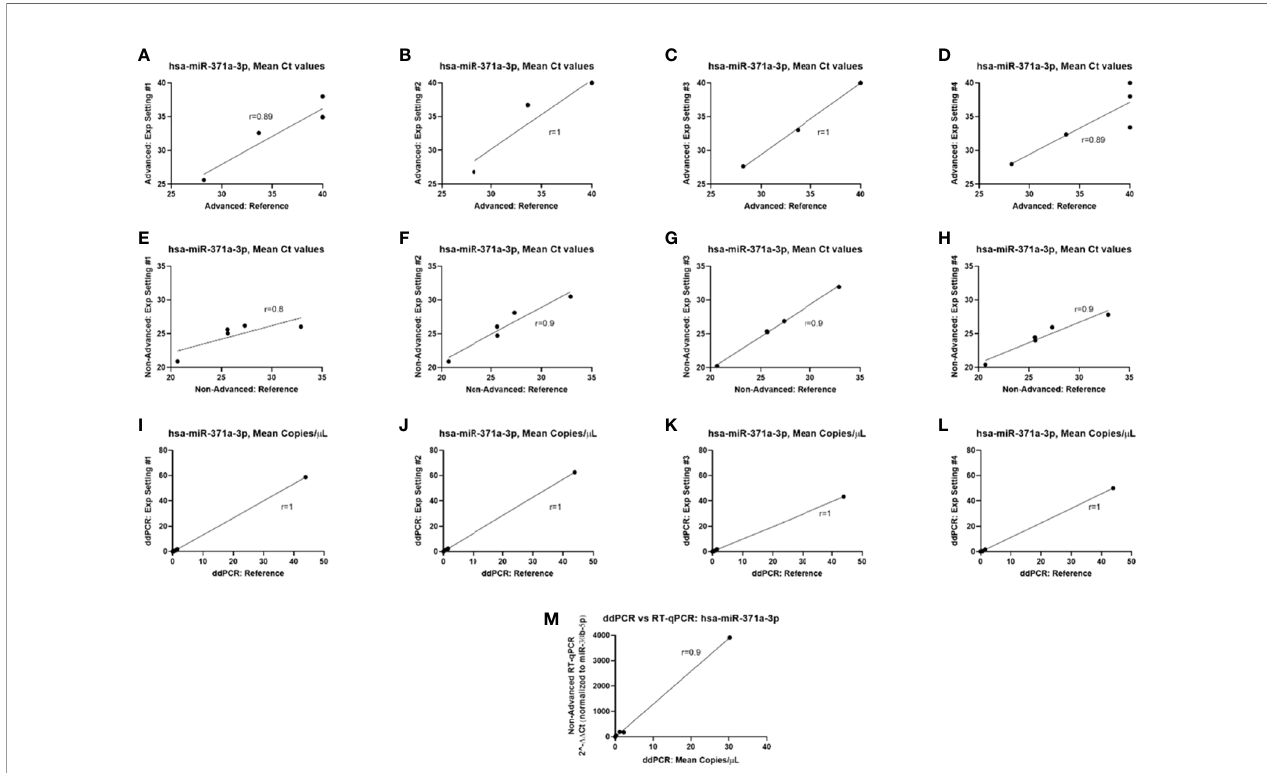
FIGURE 6 | Correlation between hsa-miR-371a-3p quanti fi cations. (A – D ) TaqMan Advanced (global) microRNA pipeline. (E – H) TaqMan (target-speci fi c) microRNA pipeline. (I – L) DigiMir pipeline. (M) Correlation between the DigiMir pipeline and the TaqMan (target-speci fi c) microRNA pipeline quanti fi cations (the latter normalized to hsa-miR-30b-5p and using the 2 − DD Ct method).